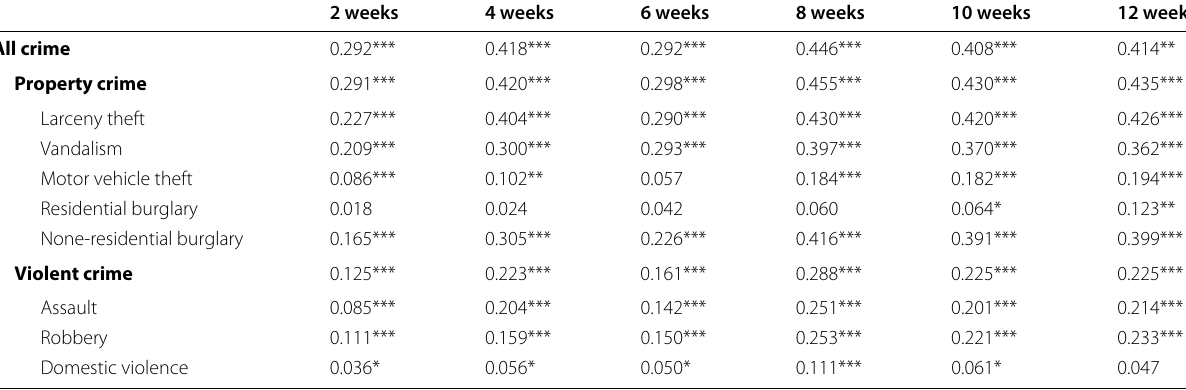
Table 1 The results of STSH index (Q statistics) between crime distribution and HAZs across six TOs in 2020 2